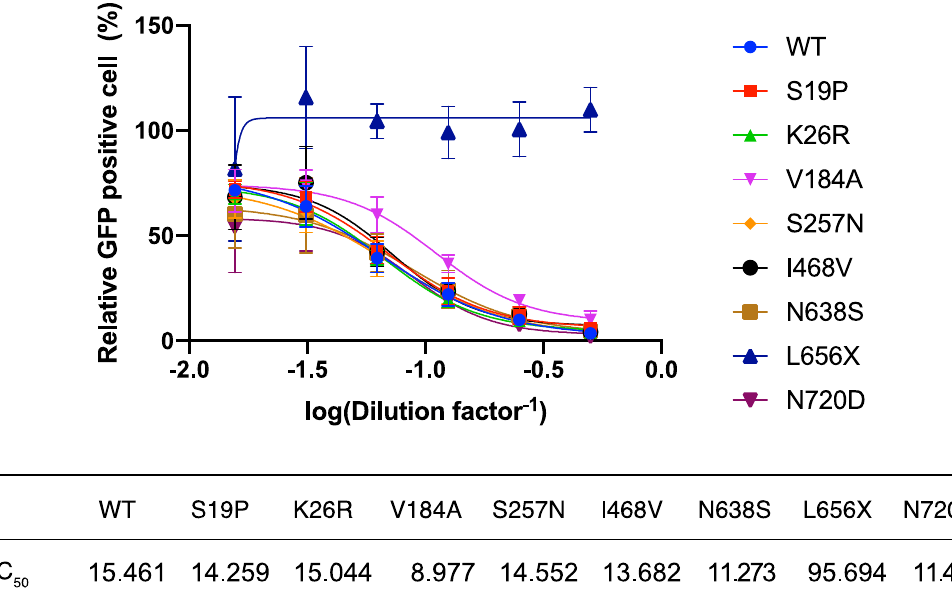
Figure 3. Neutralization assay of shedded ACE2 variants. HEK293T/ACE2 cells were inoculated with rVSV ∆ G-GFP/SARS- 2-S(D614G) pre-incubated for 1 h at 37 °C with serially diluted tissue culture supernatants (TCS) from cells transfected with wild-type (WT) ACE2- or ACE2 variant-expressing plasmids. After 16 h, the levels of virally infected (GFP + ) cells were measured with a high-content imaging system. The mean number of GFP + cells inoculated with rVSV ∆ G-GFP/SARS- 2-S(D614G) pre-incubated with the TCS from empty vector-transfected cells was set to 100%. The dilution factors required to attain 50% inhibition of viral infection (IC 50 ) were determined using GraphPad Prism 9 software. Data represent the mean ± S.D. of three independent experiments.